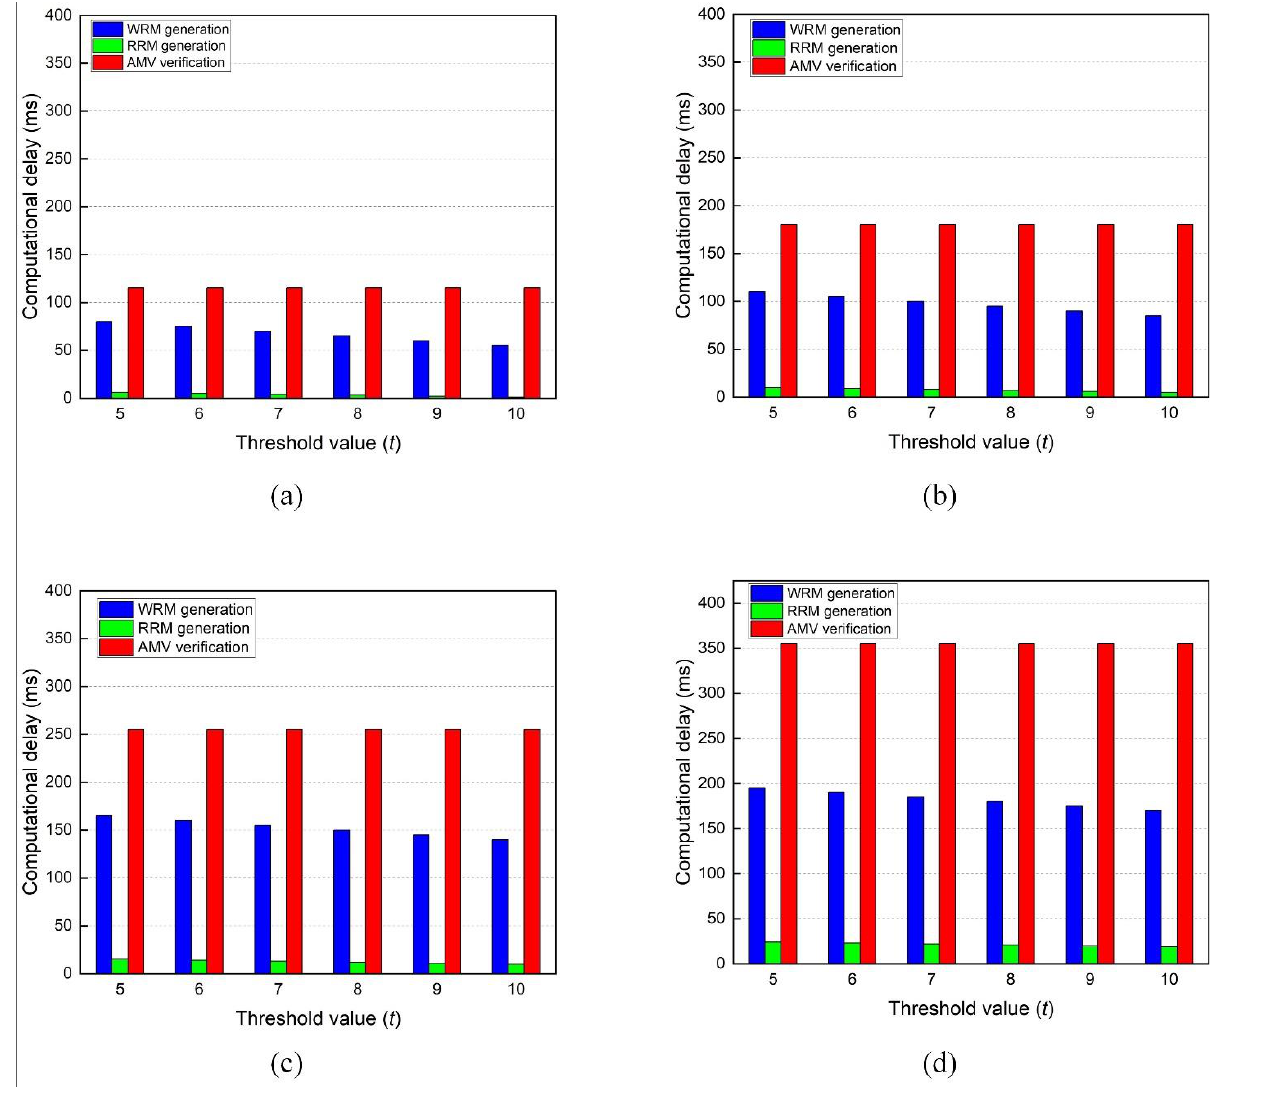
Figure 6. The cryptographic delay during WRM generation, RRM generation, and AVM verification in the proposed TRS scheme. For experiments ( a – d ), the ring-size r is fixed at 20, 30, 40, and 50, respectively.